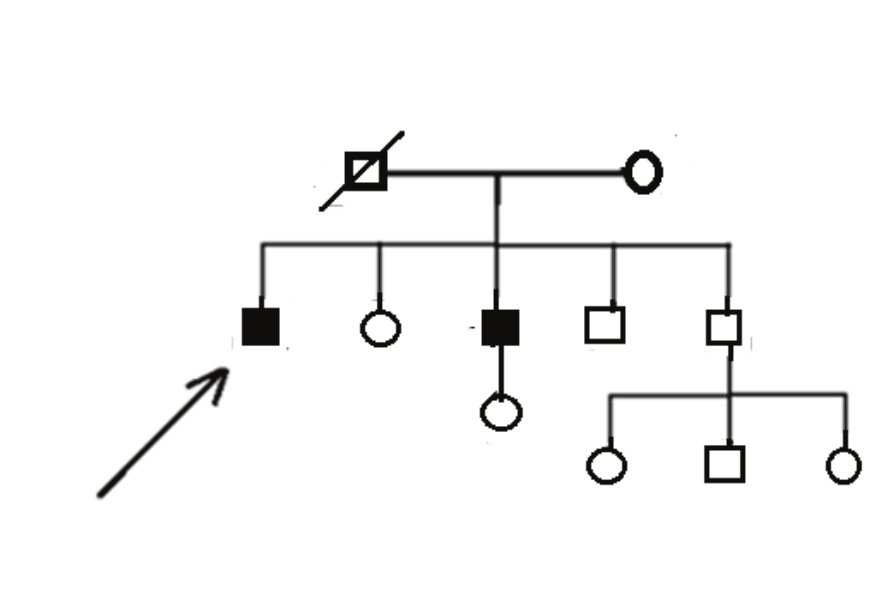
Figure 1 : Pedigree of the first family from the Northern State, Sudan with familial Bell’s palsy affecting two brothers. The arrow points to the index